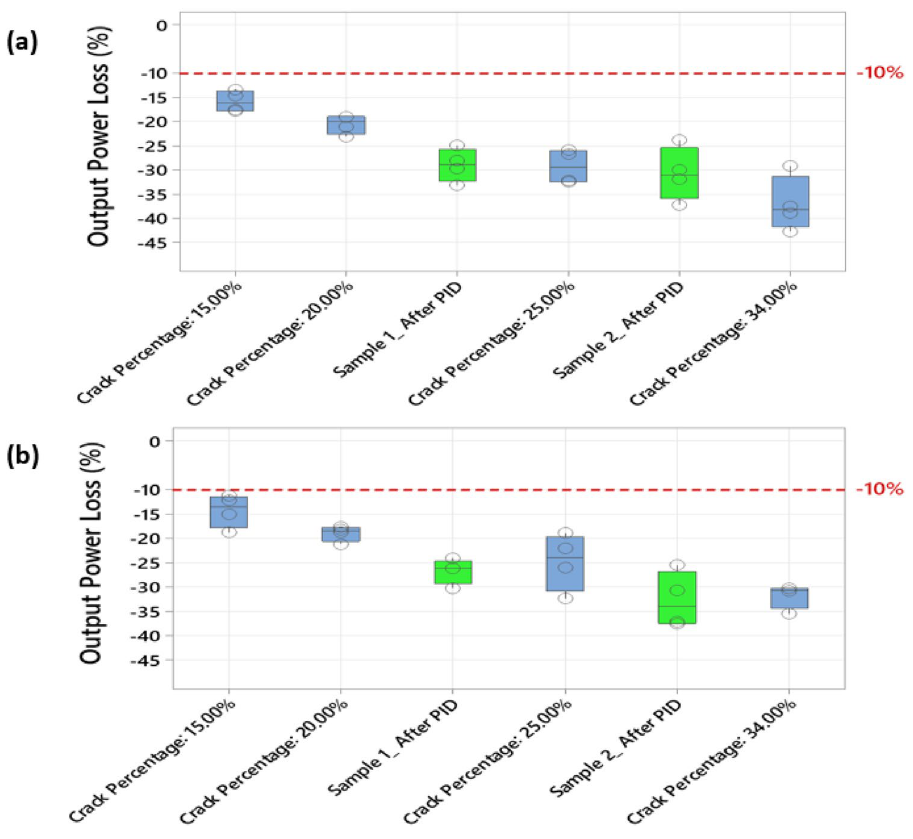
Figure 11. Calculation of the output power loss for the solar cell samples after PID test was completed, the results are also compared with the measurements taken from the cracked solar cell samples earlier shown in Fig. 6 ( a ) at 1 Sun, ( b ) at 0.5